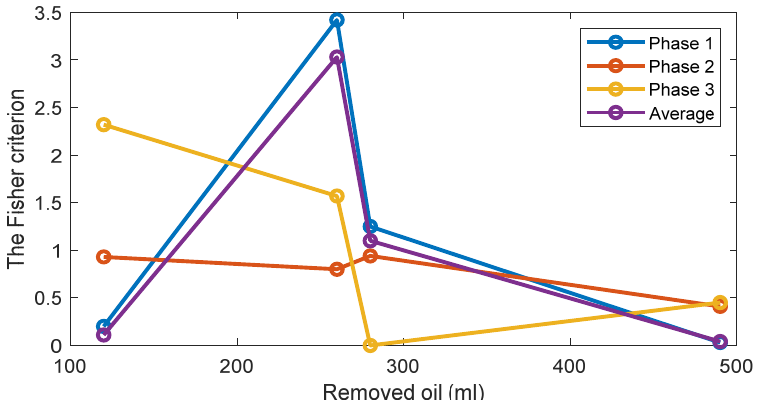
Figure 8. The FC of Feature 1 (the third harmonic of the supply frequency) for three phases and 4 levels of oil removal compared to the standard oil level (Day 1).